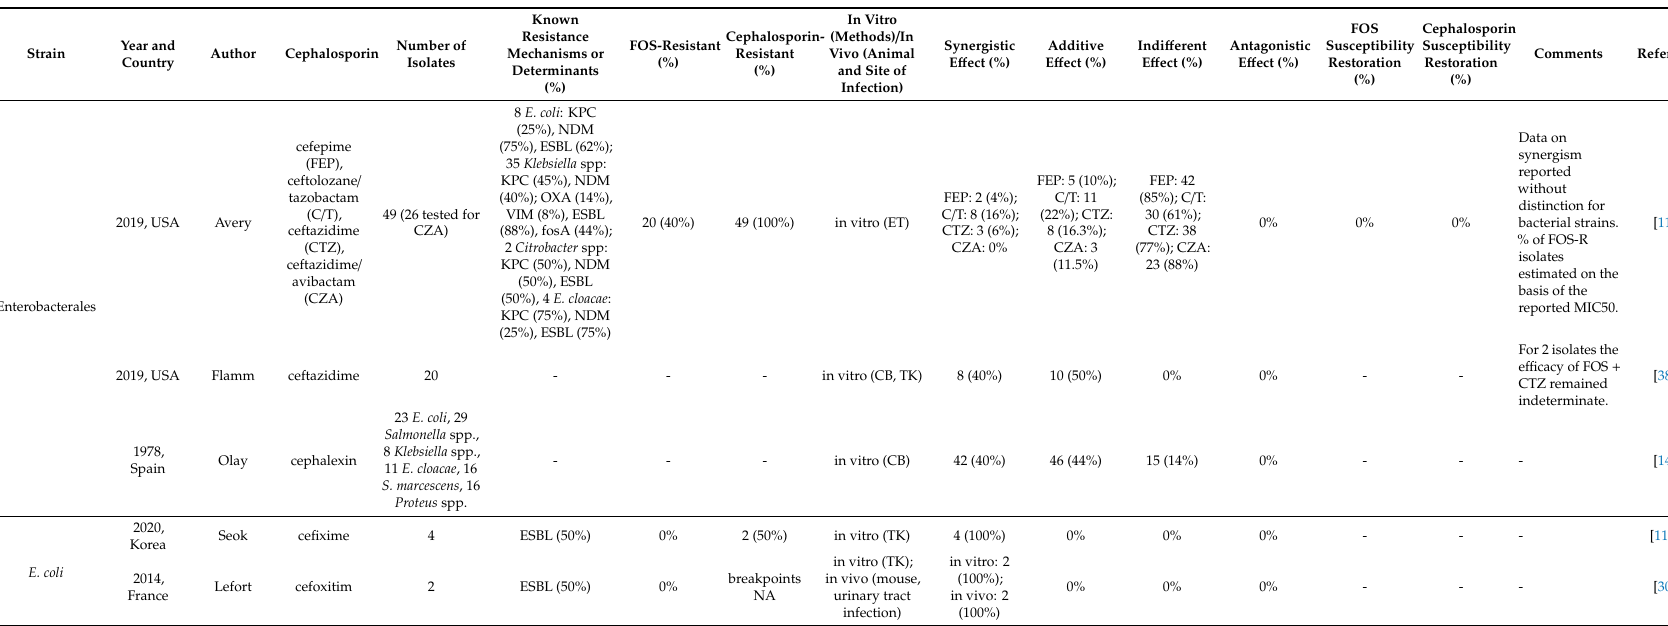
Table 2. Studies on combination between fosfomycin and cephalosporins, cephalosporins + β -lactamase inhibitors. CB: checkerboard assay; TK: time–kill assay; ET: